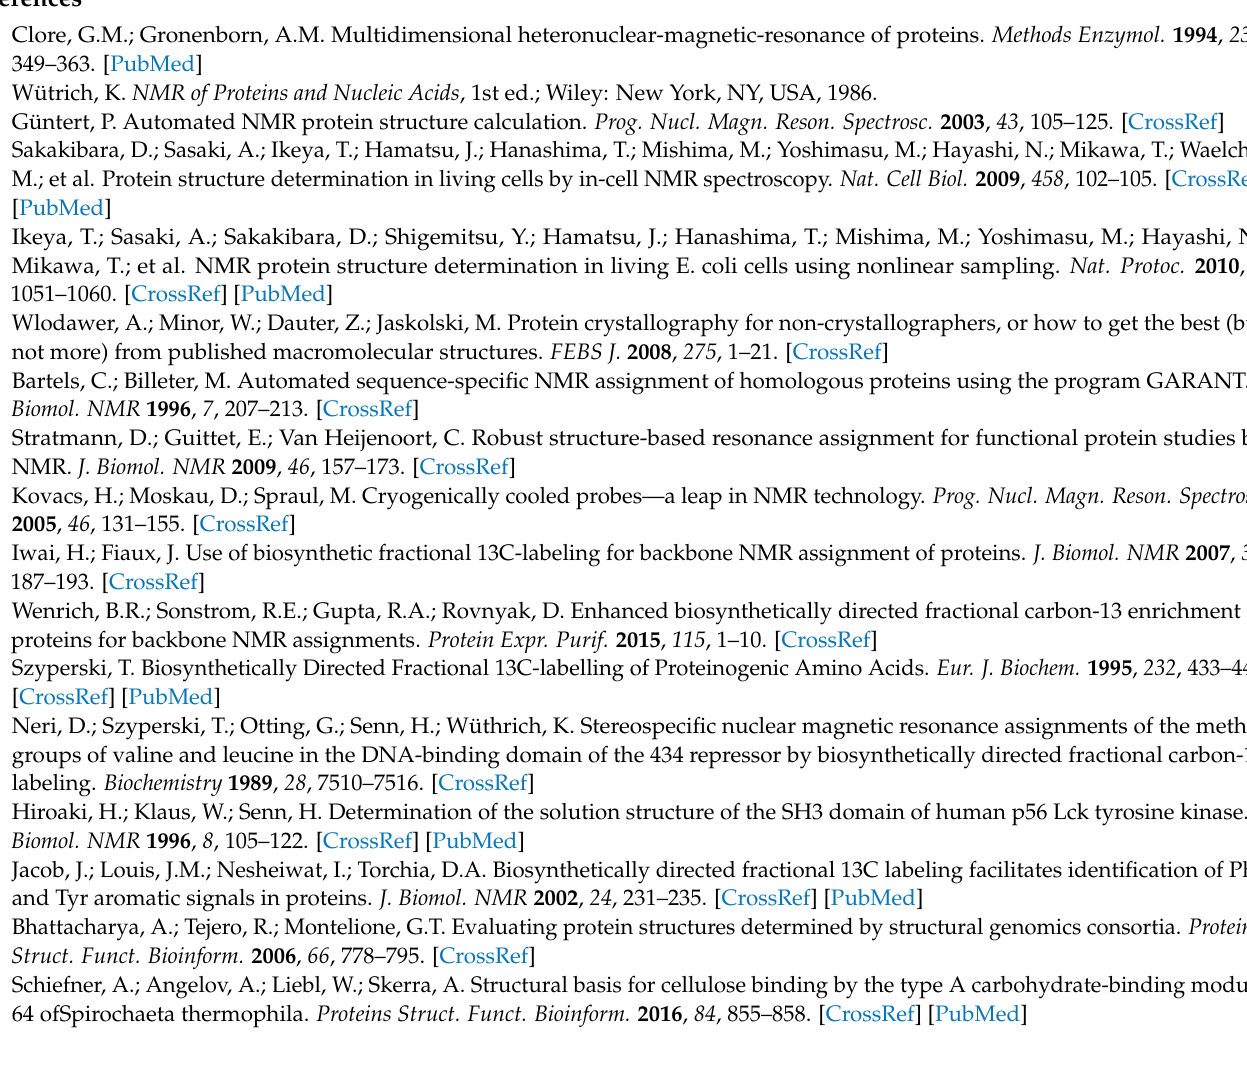
Figure S3: Titration of CBM64 by addition of cellobiose using HSQC spectra, Figure S4: 15 N relaxation analysis with and without